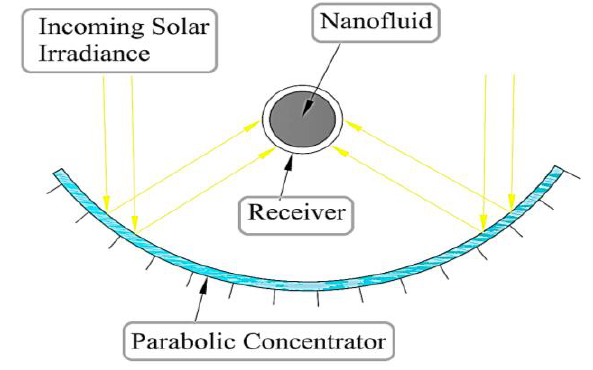
Fig. 10. Schematic diagram of parabolic concentrating solar collector using nanofluid [115].